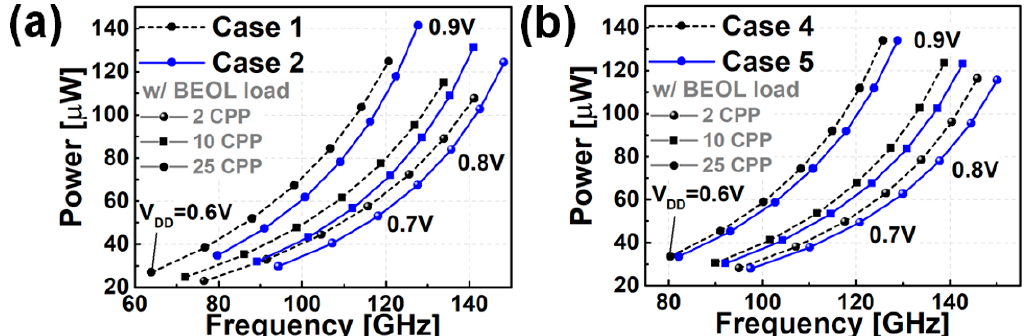
Figure 9. PPA results of nine stages RO (with BEOL load) for ( a ) without BO models (case 1 and 2), ( b ) with BO models (case 4 and 5).